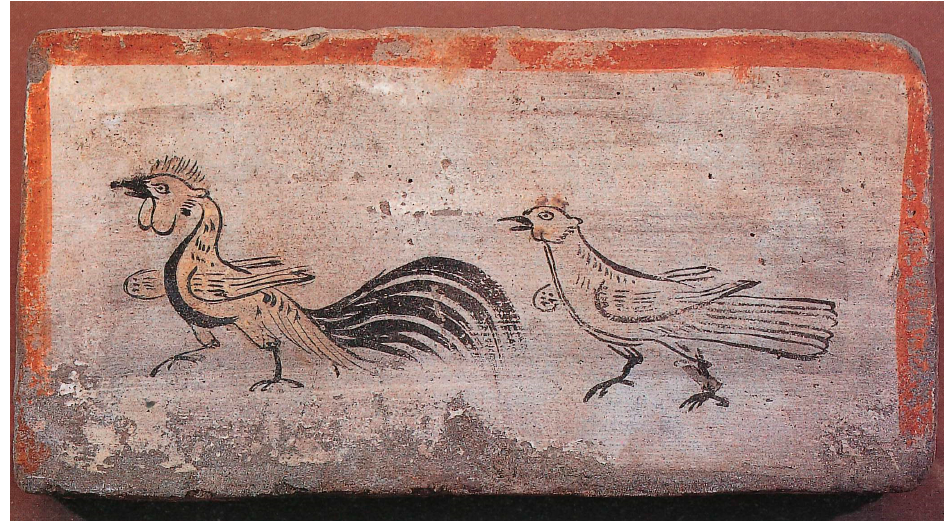
Figure 13. Two wild chickens, west wall of Foyemiaowan M39, painting on brick, Western Jin period (265–317). (Gansusheng Wenwu Kaogu Yanjiusuo 1998, pl. 60.1). ©Wenwu Press. This figure published with permission of Wenwu Press and cannot be used or copied without their